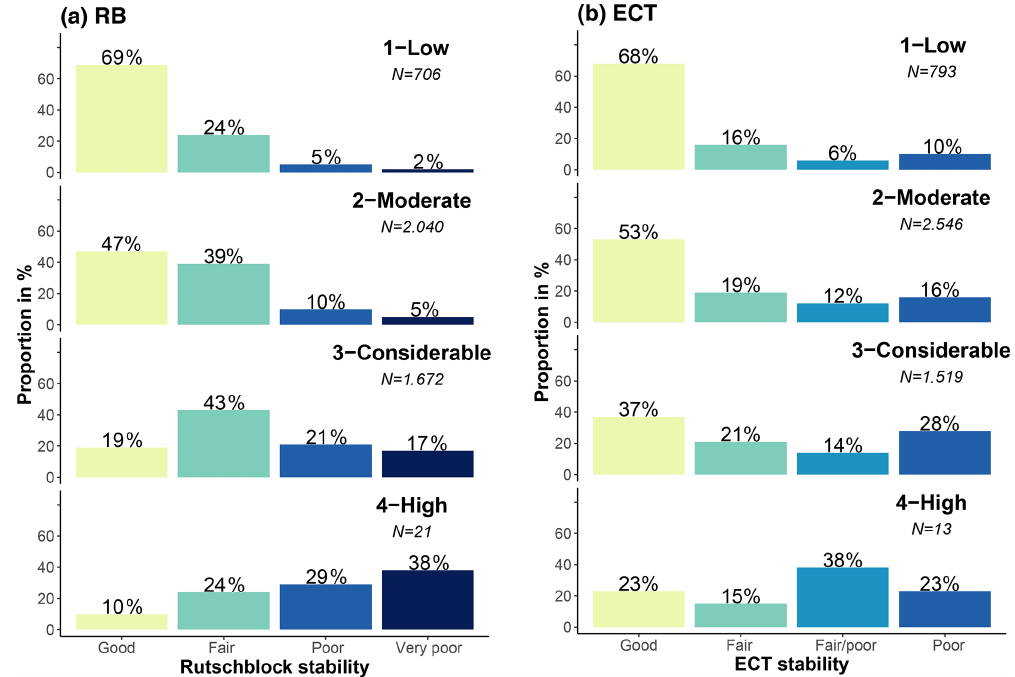
Figure 3. Distribution of stability ratings for the stability tests (a) rutschblock (RB) and (b) the ECT for danger levels 1-Low to 4-High. For the definition of the stability classes refer to Fig. 1 and Sect. 3.1. Note the small N for 4-High for both tests. Table 2. Frequency classification derived from the proportion of very poor stability ratings, using four frequency classes. The intervals for the frequency of very poor stability are shown. D (1st) and D (2nd) indicate the most frequent and second-most-frequent danger level the samples were drawn from, respectively. Also shown is the classification of the combination of stability class and frequency class based on the two most frequent danger levels, denoted as letters A to F, which will be used in Figs. 6 and 7. For class none or nearly none, no letter is assigned, as the next highest stability class should be considered. Stability Frequency Interval ∗ Danger level Letter